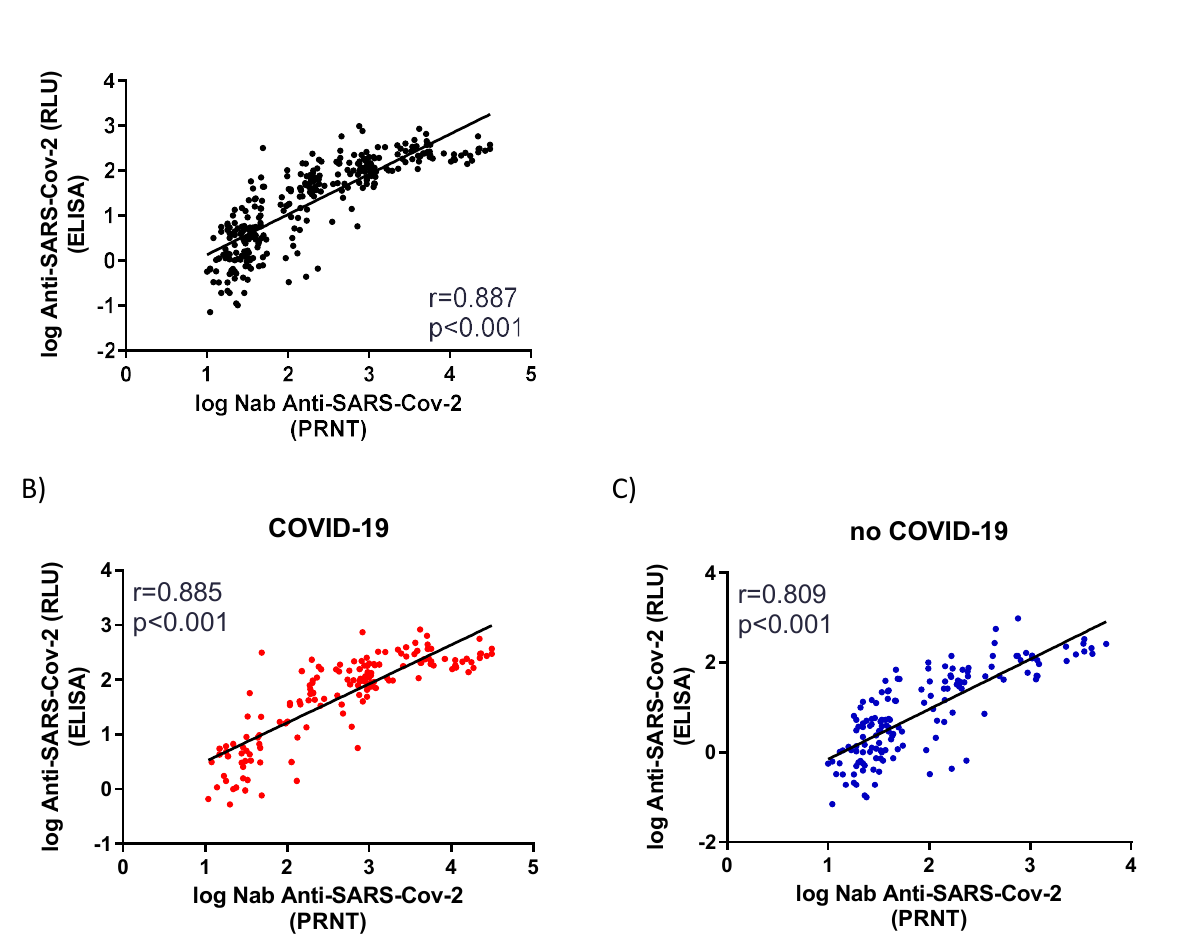
Figure 4. Correlations between neutralizing antibody (Nab) and total IgG. Graphics represent the correlation between anti-SARS-CoV-2 Nab and total IgG anti-RBD represented in RLUs. Panel ( A ) represents the correlation of all samples collected at 0, 7, 15, 90, and 120 DAV. Panels ( B , C ) represent correlations of values obtained at 120 DAV considering individuals without (noCOVID-19) or with (COVID-19) pre-vaccination SARS-CoV-2 infection, respectively. R and p values were obtained by Spearman correlations. DAV = days after vaccination. RLU = relative luminescence